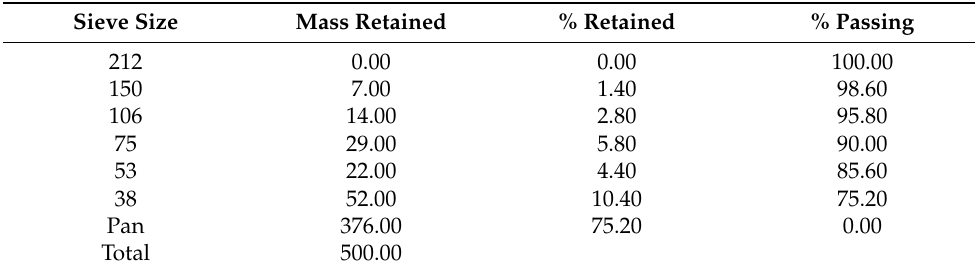
Table 3. Particle size distribution of the calcine leach